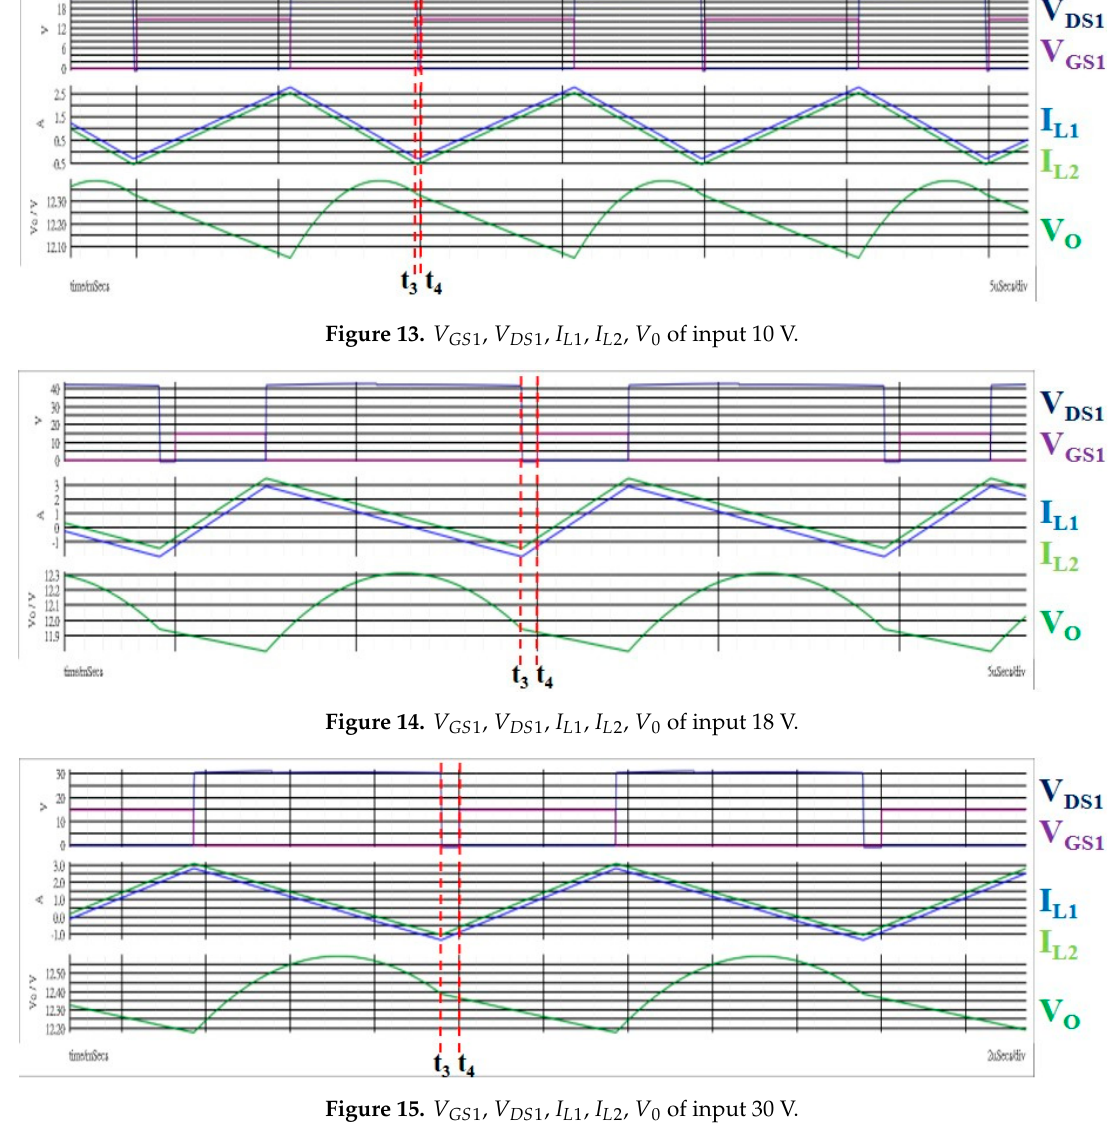
Figure 16. V GS 1 , V DS 1 , I L 1 , I L 2 , V 0 of input 40 V. Measured Waveform The SEPIC circuit with zero voltage switching, mentioned in this paper, uses a high-voltage DC power supply for input signal stability and low noise. The two driver ICs use a small power supply GPD3060D, and the load is simulated using a Chroma load machine. The output terminal is connected to the OLED, and a differential isolation carbon rod is used to side the waveform of the power switch. The current waveform uses a current probe that can measure 30 A. Measurement of the SEPIC circuit with zero voltage switching is adopted. The switching signal uses a digital control method. The circuit uses two power switches. Thus, to prevent the two power switches from malfunctioning and causing component damage, a dead-time mechanism is added to the control aspect to ensure that the V GS of the two power switches are staggered when they are turned on and that the V GS of the second power switch is delayed for some time before turning on. The duty cycle of the two power switches is at a complementary mode. The measured waveforms are shown in Figures 17 and 18. The input voltages are 10 V and 40 V. The duty cycle of the two power switches is at a complementary mode. The switching frequency is 70 kHz; thus, it outputs two power switch waveforms and inductor current waveforms with a fixed 12 V current of 1 A. As shown in Figures 19–21, the input voltages are 10 V and 40 V, the duty cycle of the two power switches is at a complementary mode, and the switching frequency is 100 kHz. Thus, it outputs two power switches with a fixed 12 V current 1 A. The waveform and the inductor current waveform can be verified for consistency with the theoretical waveform by measuring the waveform at different input voltages and switching frequencies. The measured waveforms, simulated waveforms, and theoretical waveforms are consistent and verify feasibility.